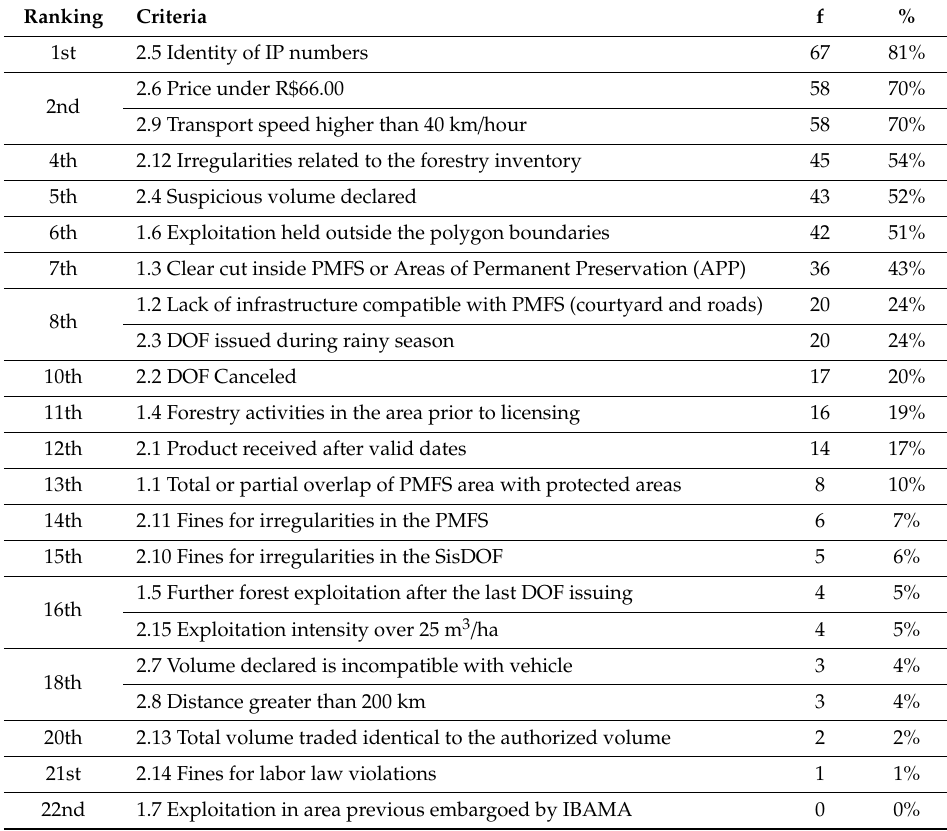
Table 4. Frequency ranking by